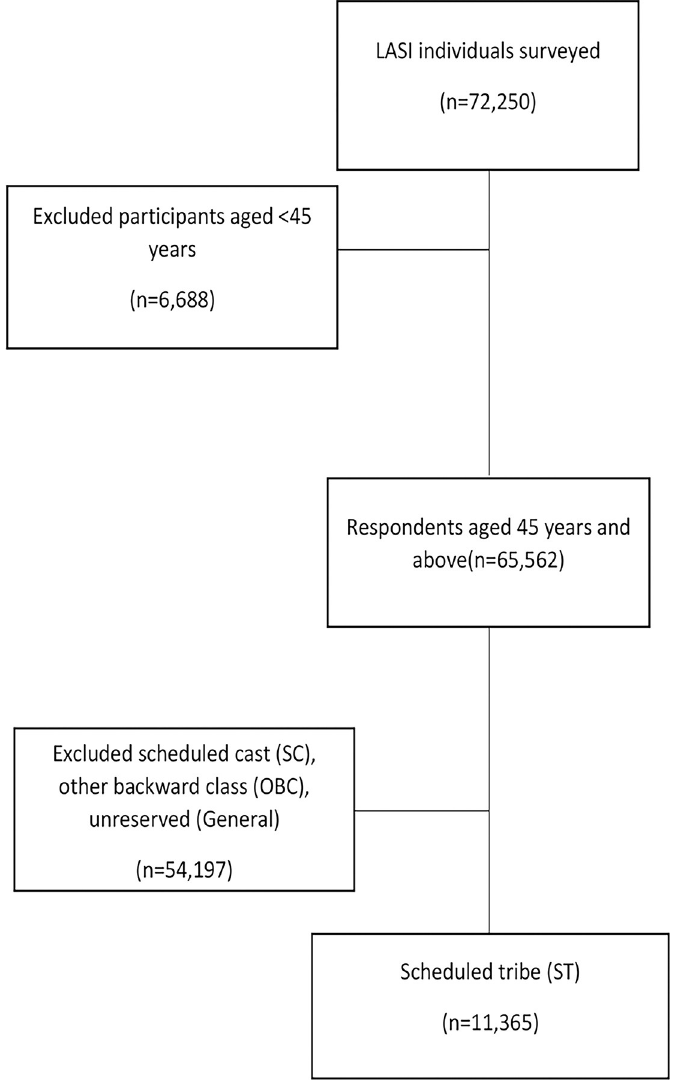
Fig 1. Selection of study